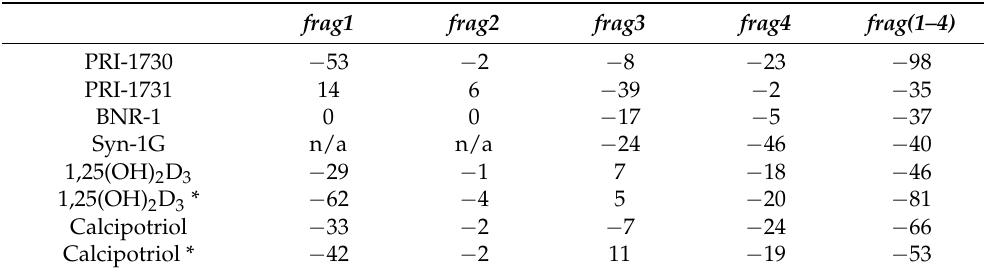
Table 4. E es (kcal mol − 1 ) calculated for the interaction between the analysed vitamin D analogue fragments ( frag1 – frag4 ) and the cluster of molecules based on the EP/MM method implemented in VMoPro. Details are in Section 3.6.3.